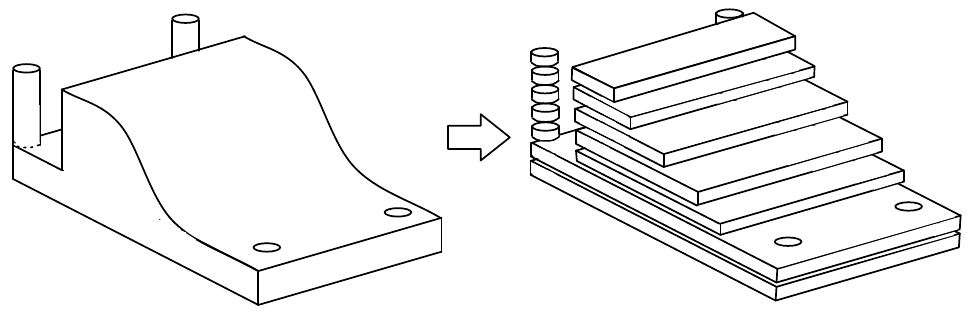
Fig. 1 Sketch of the slicing procedure, at the beginning of all additive manufacturing